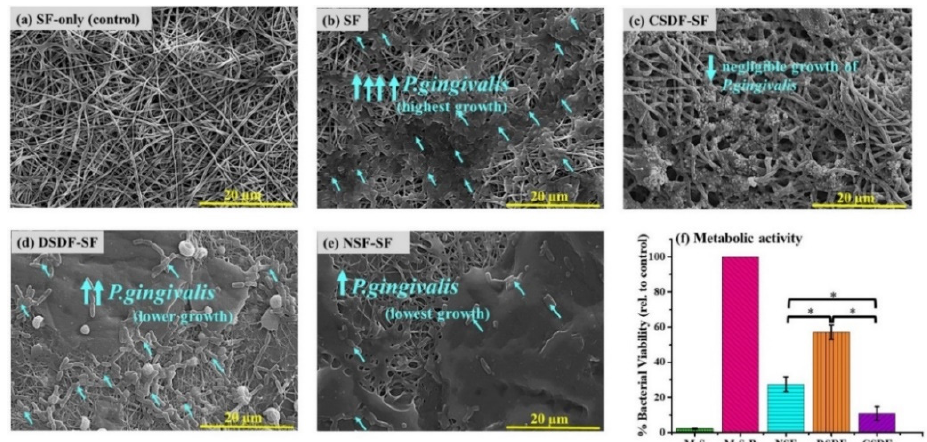
Figure 3. ( a – e ) SEM images showing the bacterial adhesion on the SF-based samples, and ( f ) the quantitative estimation of the metabolic activity by MTT assay (* depicts p -value < 0.05).